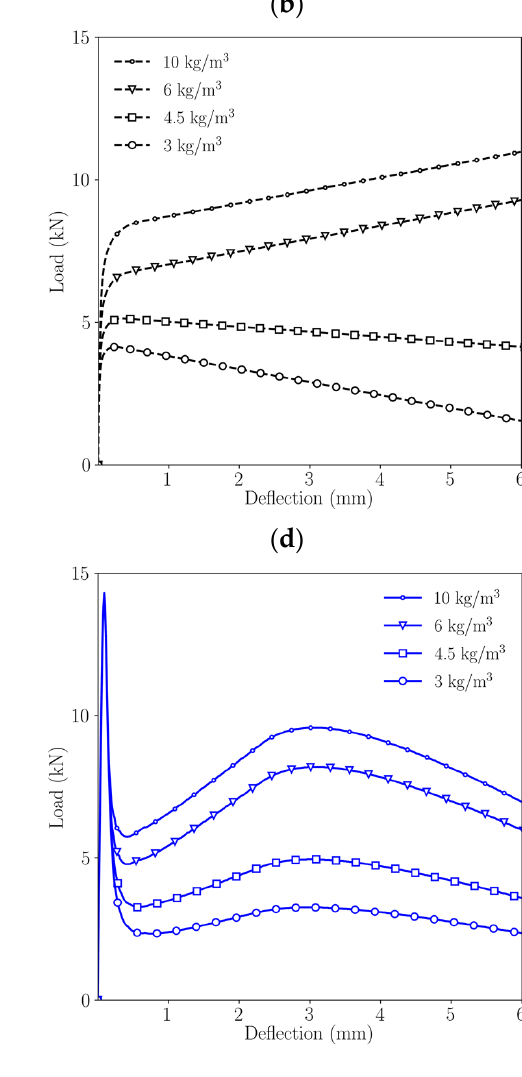
Figure 7. Comparison of the load-deflection diagram obtained with each approach for different fibre dosages: ( a ) rigid-plastic model, ( b ) linear elastic model (unlimited development), ( c ) linear elastic model (limited development), ( d ) trilinear model.